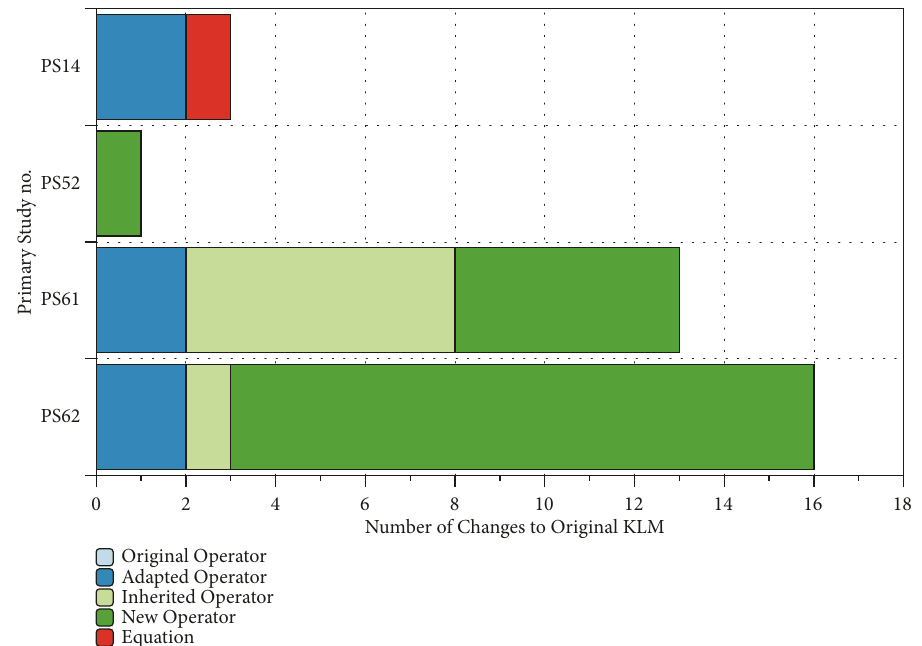
Figure 12: The number of original operators preserved, adapted, inherited from other extension or literature, and newly introduced in the touch-based IVIS